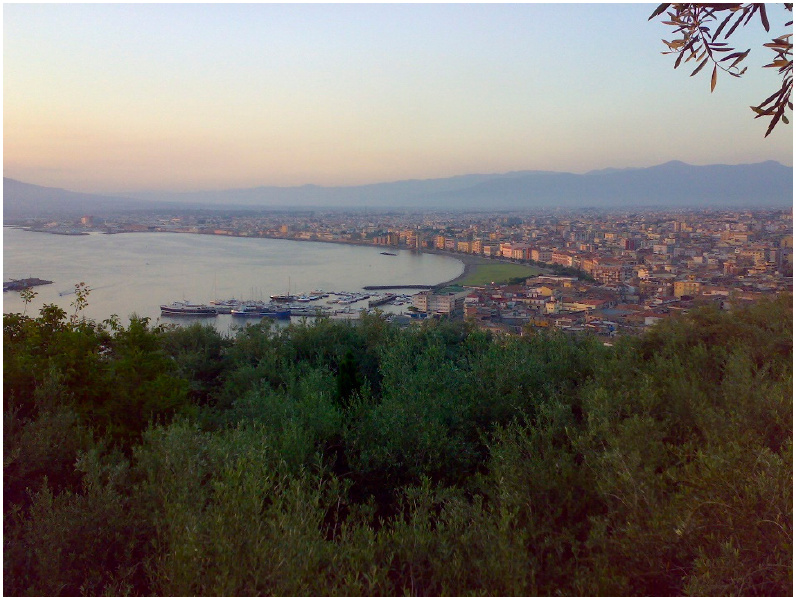
Figure 9. Wide triangular-shaped sandy beach of Castellammare di Stabia with a maximum width of about 150 m.